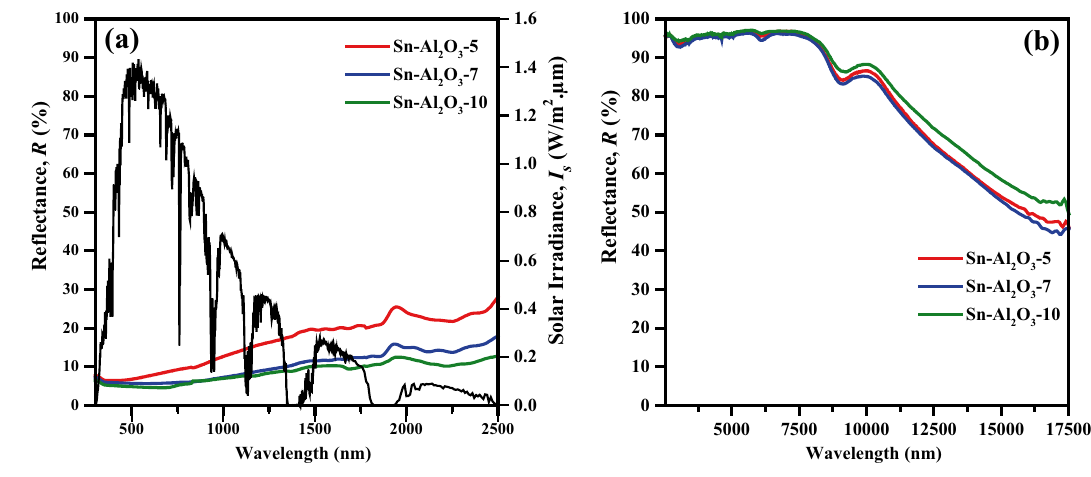
Fig. 5 Spectral reflectance ( R ) of Sn–Al 2 O 3 solar absorber with different Sn contents in the wavelength range of a the UV–Vis-NIR regions compared with the solar spectrum at AM 1.5 and b the IR region